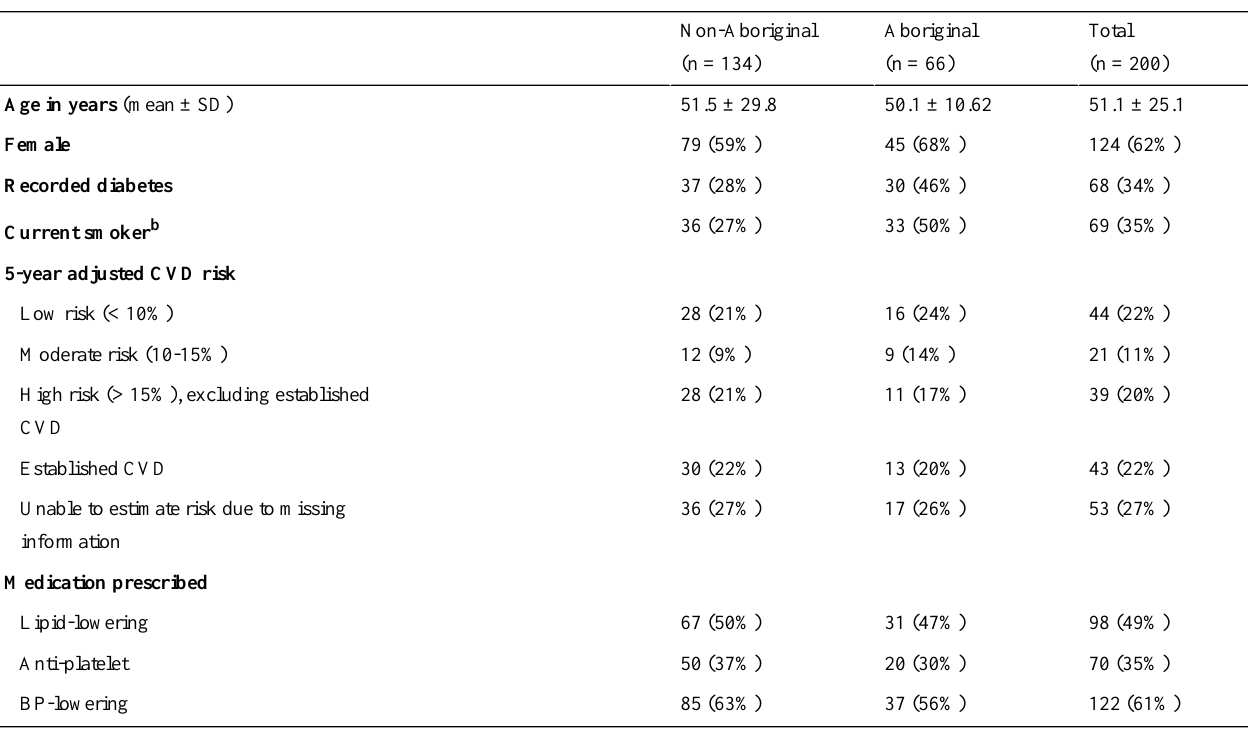
Table 2. Baseline risk assessment characteristics of 200 patients attending their GP